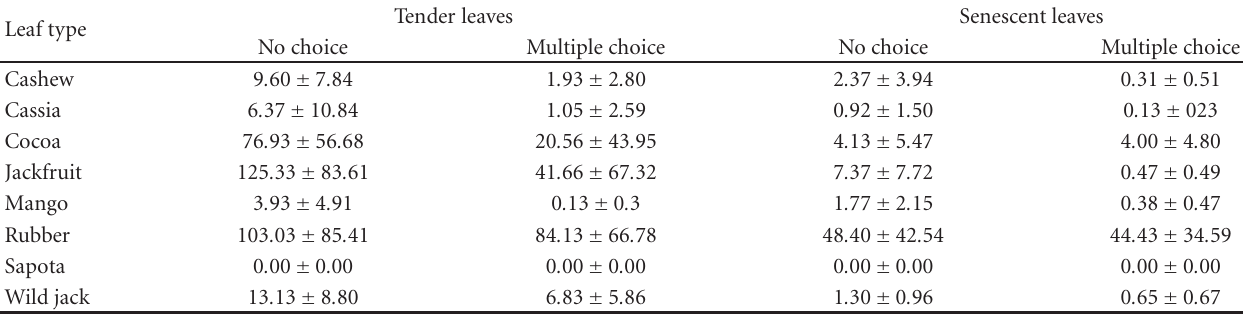
Table 1: Quantity (mm 2 ) of leaves consumed (mean ± SD) by L. tristis in multiple and no-choice experiment tests.